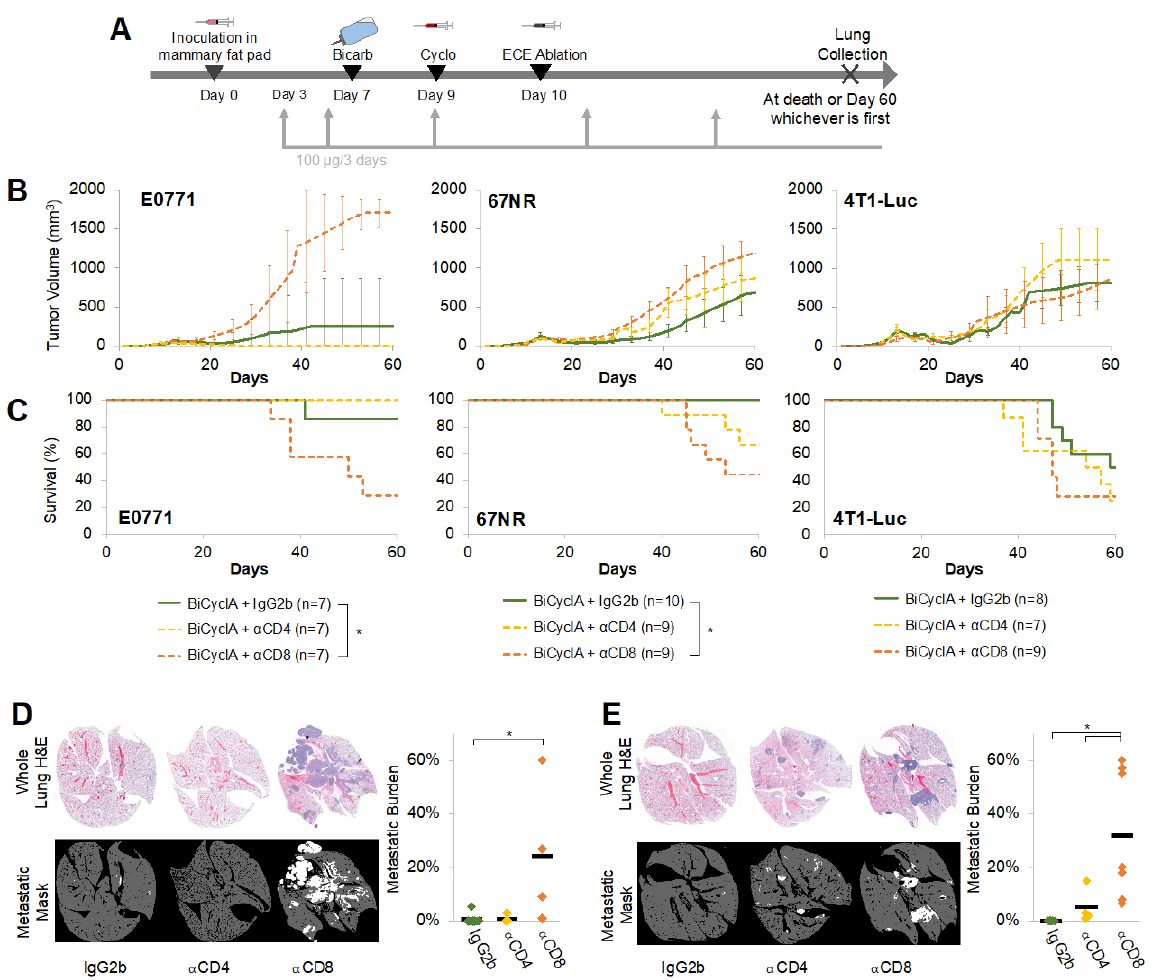
Figure 3. CD8+ cells contributed to the anti-metastatic effects of BiCyclA therapy. ( A ) Depletion study timeline. ( B ) Tumor volumes and ( C ) survival rates after bicarb + cyclo + ablation with or without depletion for mice with E0771, 67NR, and 4T1-Luc tumors. ( D ) Representative H&E, masks, and metastatic burden for mice bearing 67NR tumors. ( E ) Representative H&E, masks, and metastatic burden for mice bearing 4T1-Luc tumors. * p < 0.05; KS test ( B ) or Student’s t -test ( C , D ).